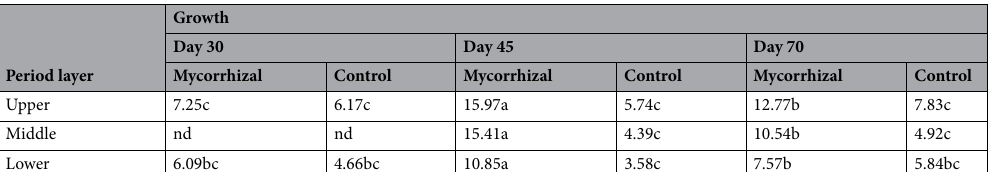
Table 2. Net photosynthetic rate of peanut under different treatments at different canopy layers and growth periods in μmol m −2 s −1 . Within each row, mean values not followed by the same letter are significantly different by LSD ( p < 0.05); nd, not